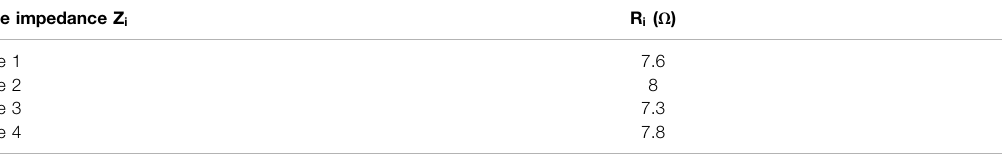
TABLE 2 | Electrical parameters of the interconnecting lines.